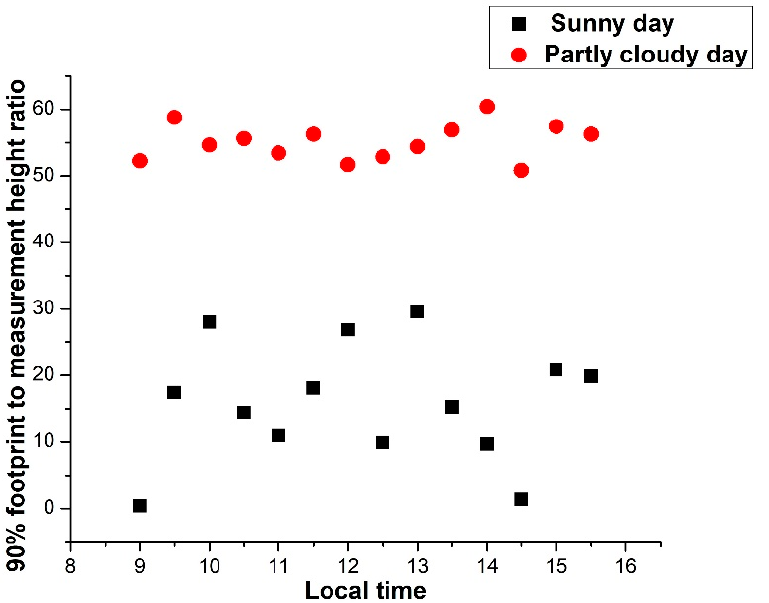
Figure 4. Variation of half-hourly 90% footprint measurement height ratio of two different days [23].